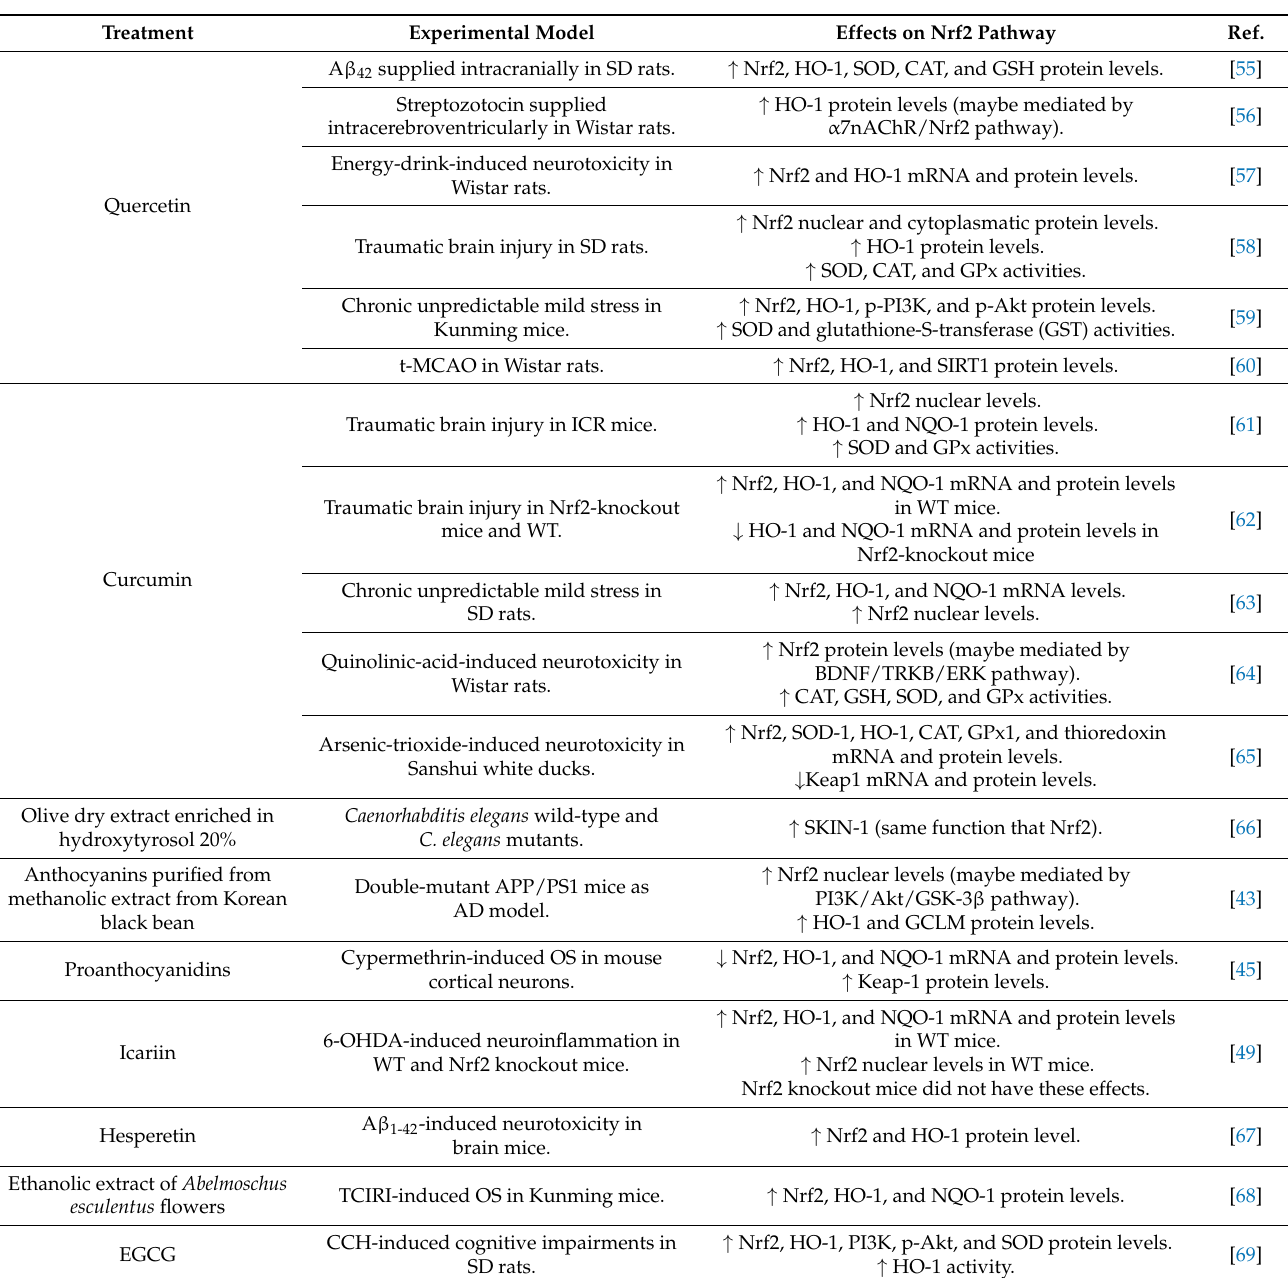
Table 2. Modulation of phenolic compounds on Nrf2 pathway in in vivo models. The increase in protein or RNAm levels are represented with ( ↑ ) and decrease is represented with ( ↓